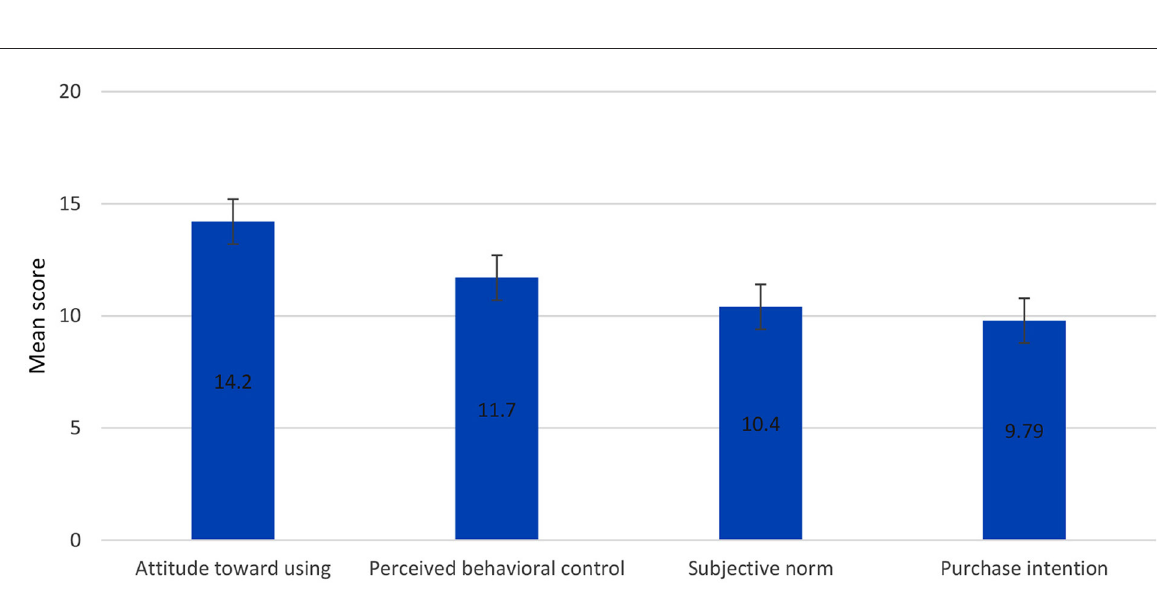
FIGURE4 Mean distribution of attitude toward using, perceived behavioral control, subjective norm and purchase